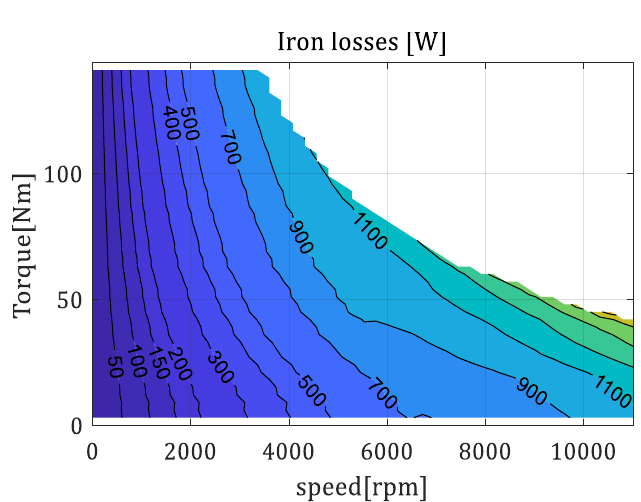
Figure A1. Copper loss map from FEA.